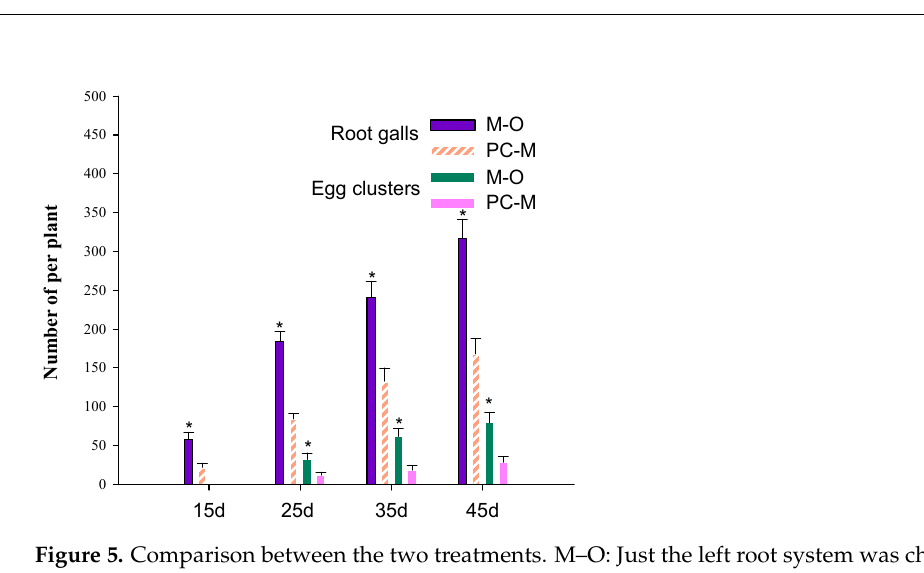
Figure 5. Comparison between the two treatments. M–O: Just the left root system was challenged with Meloidogyne incognita . PC–M: The left root system was pre-inoculated with PC-170, while the right was challenged with M. incognita . Each value is the mean ± SE ( n = 10). * indicates statistical differences between treatments ( p < 0.05).